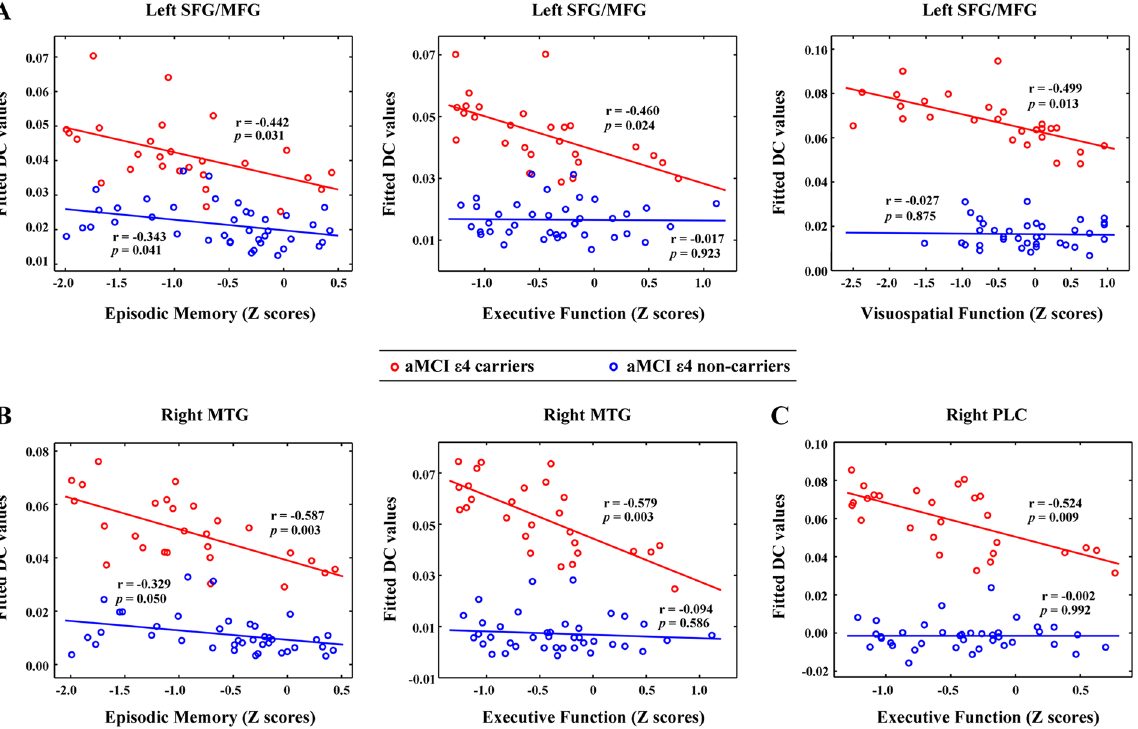
Figure 4. Relationship between the cognitive performance and regional DC values in the aMCI patients. The scatter plots showed correlations between the cognitive performance and regional DC values in the left SFG/ MFG ( A ), right MTG ( B ) and right PLC ( C ) in the aMCI ε 4 carriers (red circles) and the aMCI ε 4 non-carriers (blue circles). Note that no significant correlations were observed between the DC values in these regions and cognitive performances in the HC ε 4 carriers and HC ε 4 non-carriers (all Ps > 0.05). DC, degree centrality; aMCI, amnestic mild cognitive impairment; HC, healthy control; SFG/MFG, superior/middle frontal gyrus; MTG, middle temporal gyrus; and PLC, posterior lobe of the